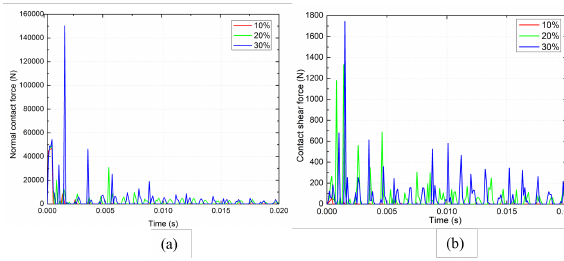
Figure 19: Transient response of debonded models a) normal con- tact force b) contact shear